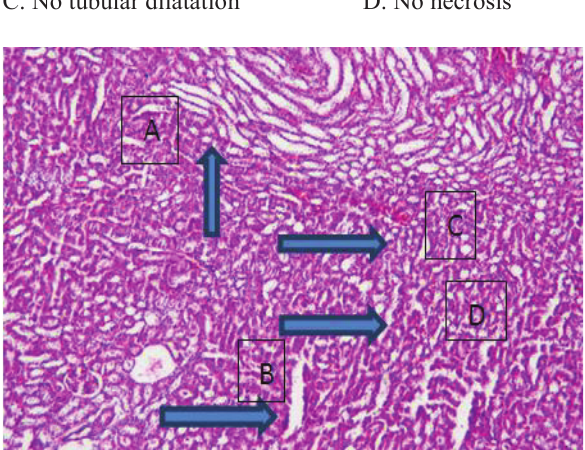
Fig-2: Showing Kidney damage by MTX in group 2